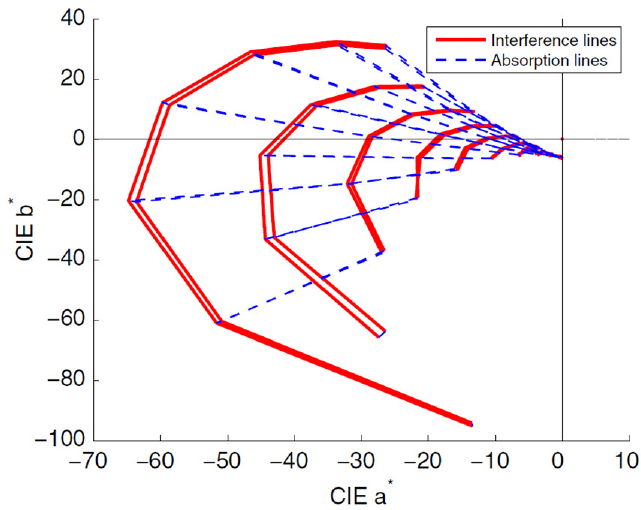
Figure 1. Color shift of a highly goniochromatic interference-based special effect coating (reprinted with permission from [9] c (cid:13) The Optical